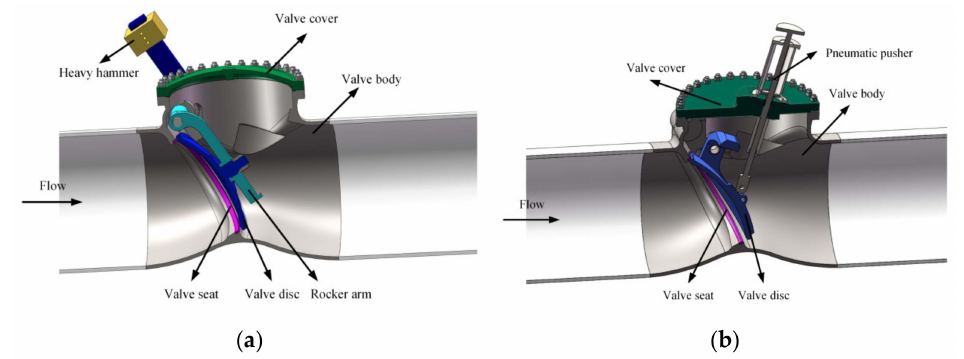
Figure 1. The structure of the investigated check valves: ( a ) the swing check valve; ( b ) the tilting check